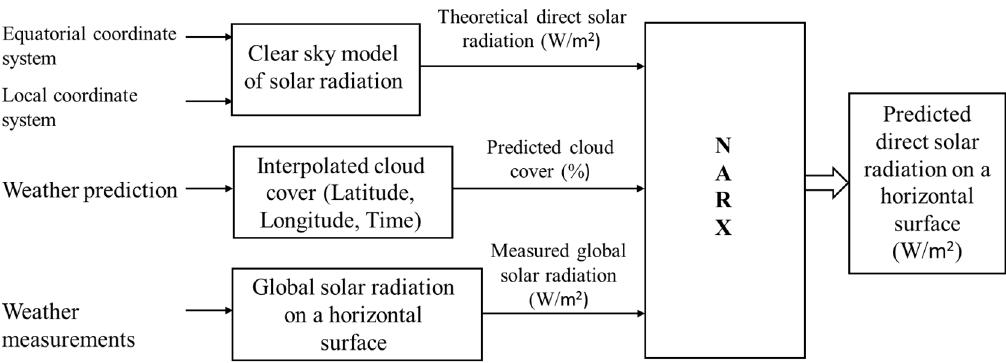
Figure 3. Inputs and output for the proposed NARX neural network model.